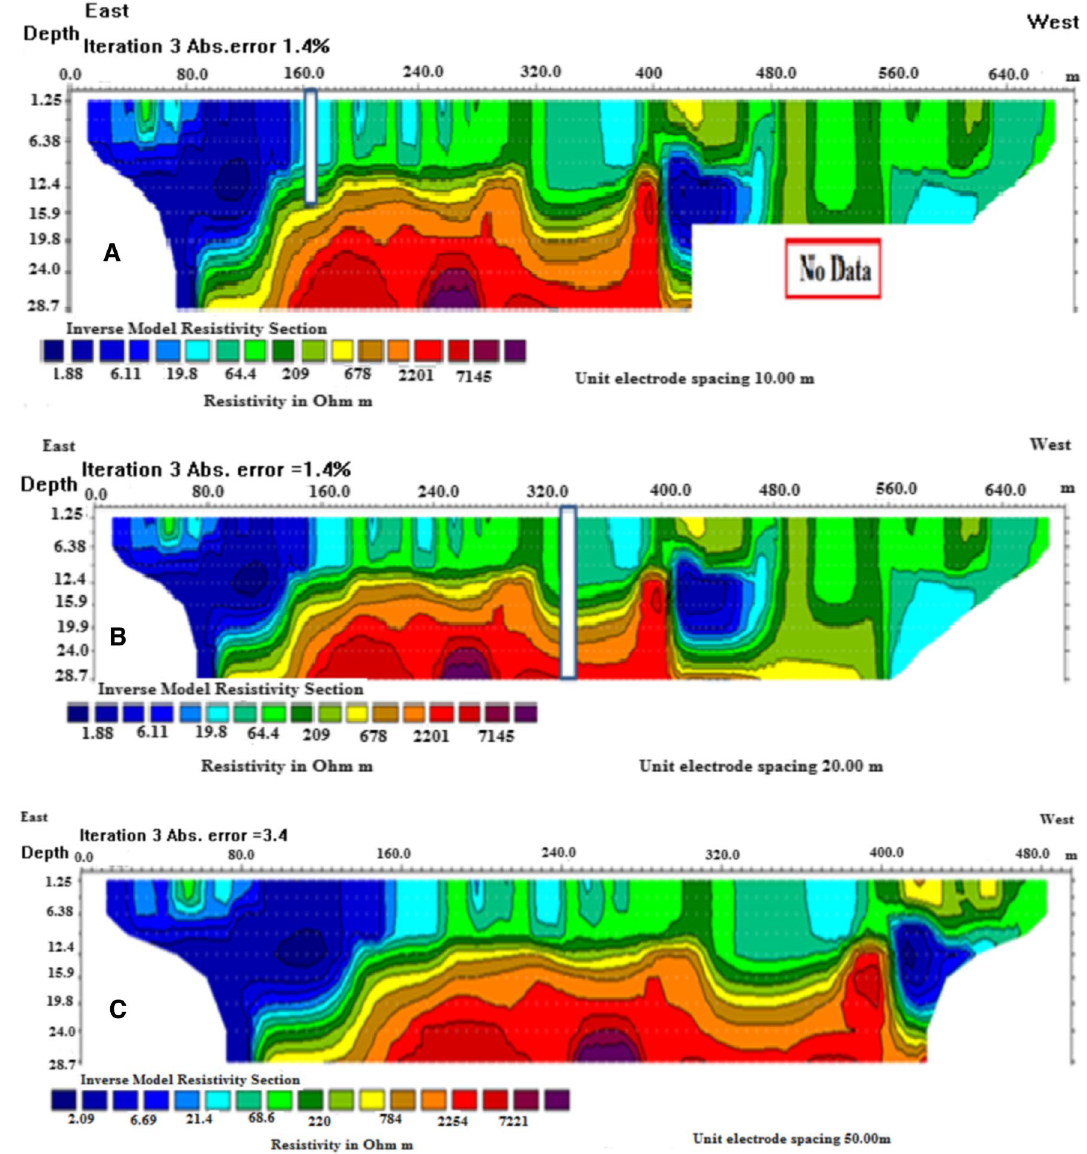
Fig. 6 2D ERT obtained from east–west profile; a acquired with 10 m; b 20 m; and c 50-m intervals spacing of Wenner arrays (while white